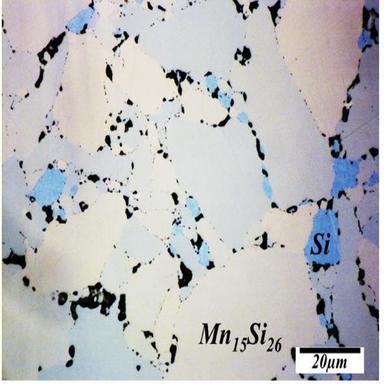
Optical micrographs of: a) MnSi1.77 and b) Mg2Si0.6Sn0.4.